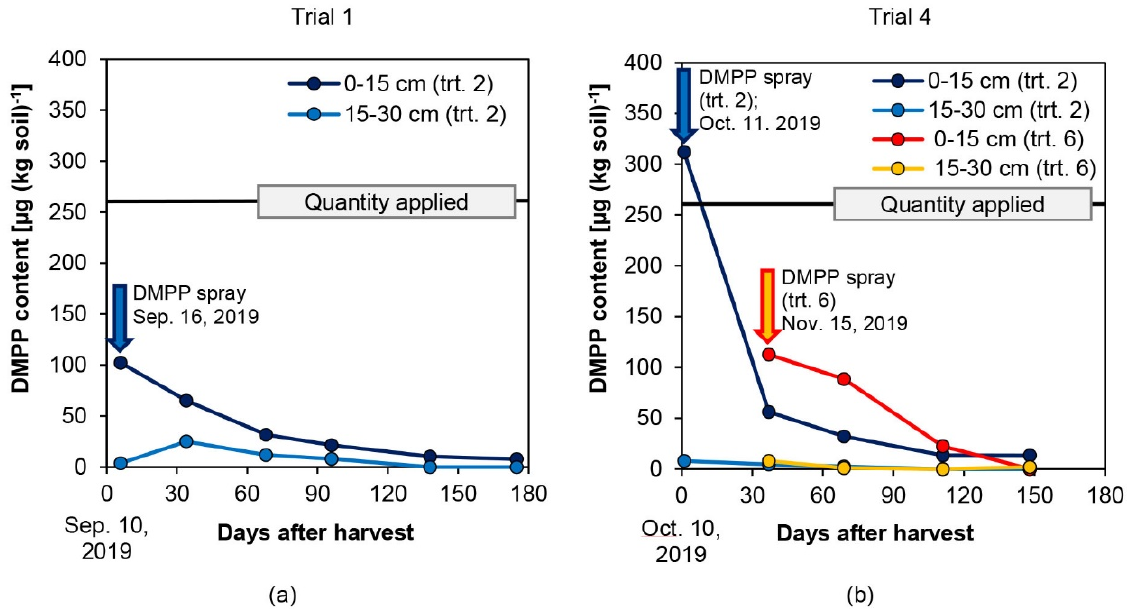
Figure 8. Content of the nitrification inhibitor 3,4-Dimethylpyrazole phosphate (DMPP) within the upper soil layers (0–15 and 15–30 cm) after application to the spinach crop residues and subsequent harrowing into the soil in ( a ) trial 1 and ( b ) trial 4 ( n = 1). Trt =